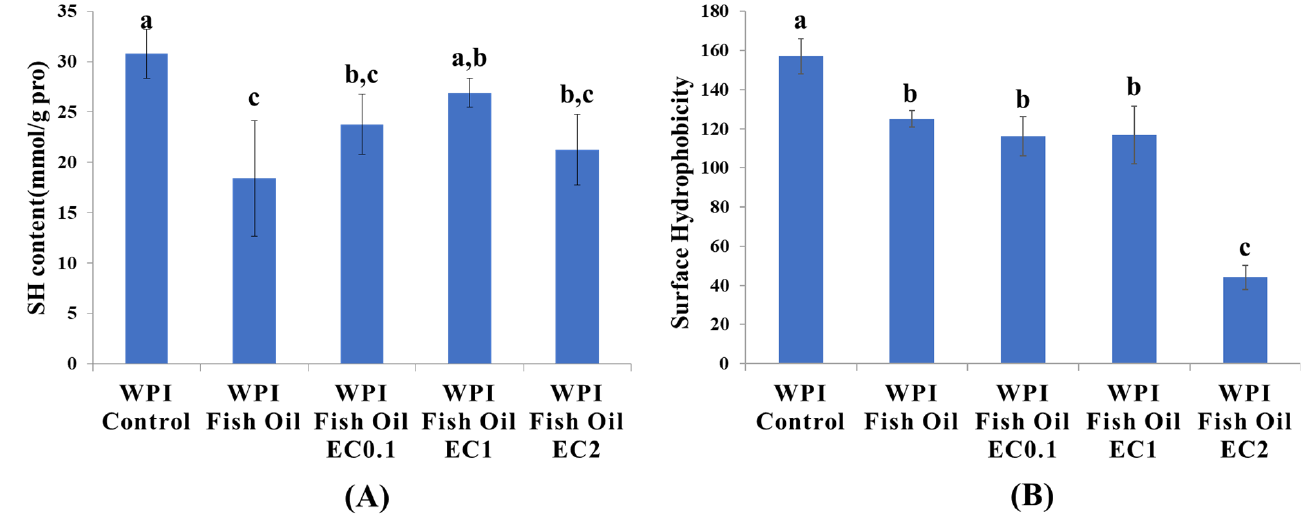
Figure 3. Total SH groups ( A ) and surface hydrophobicity of WPI ( B ) in fish oil-fortified emulsions incubated at 25 °C for 24 h in the absence or presence of EC (0.1~2 mM). Means ( n = 3) of groups with no common letter (a–c) differ significantly ( p < 0.05).